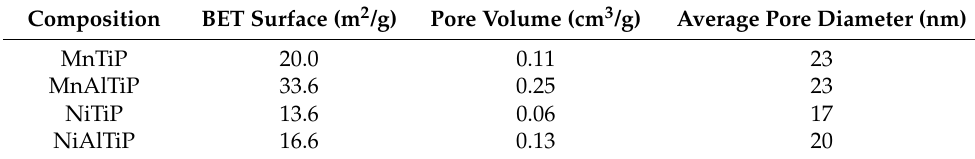
Table 2. BET surface area and porous characteristics of the compounds M 0.5(1+x) Al x Ti 2-x (PO 4 ) 3 . Composition BET Surface (m 2 /g) Pore Volume (cm 3